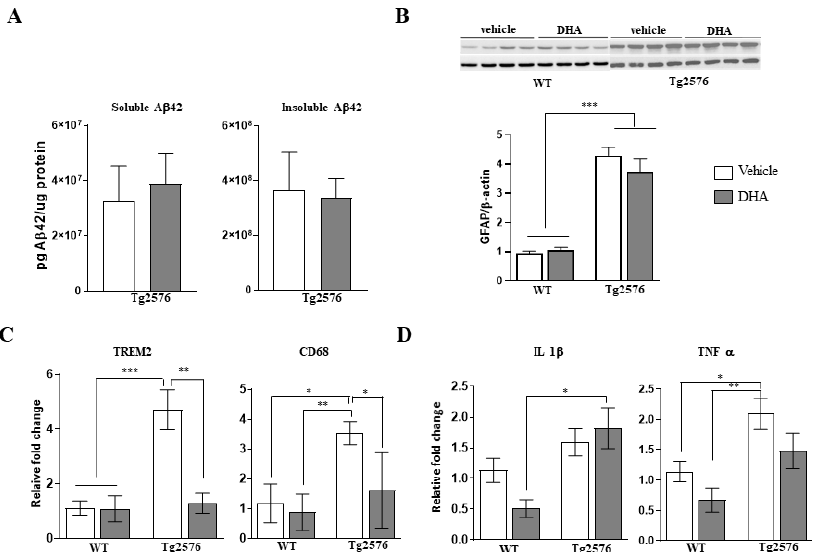
Figure 2. Amyloid pathology and neuroinflammatory markers in the brains of WT and Tg2576 mice chronically treated with DHA. ( A ) Levels of soluble and insoluble human A β , as quantified by ELISA in Tg2576 mice treated with DHA or vehicle. ( B ) Western blots showing the effects of DHA or vehicle treatment in WT and Tg2576 mice on GFAP expression, normalized to actin, in 2% SDS hippocampal extracts. ( C , D ) The mRNA expression level of microglia markers (TREM2 and CD68) and proinflammatory markers (IL1 β and TNF α ) were assessed by qRT-PCR. In all figures, results are expressed as mean ± SEM (n = 4–8 per group). Two-way analysis of variance (ANOVA) and Tukey’s post hoc test were used for statistical analyses, * p ≤ 0.05, ** p ≤ 0.01, *** p ≤ 0.001.